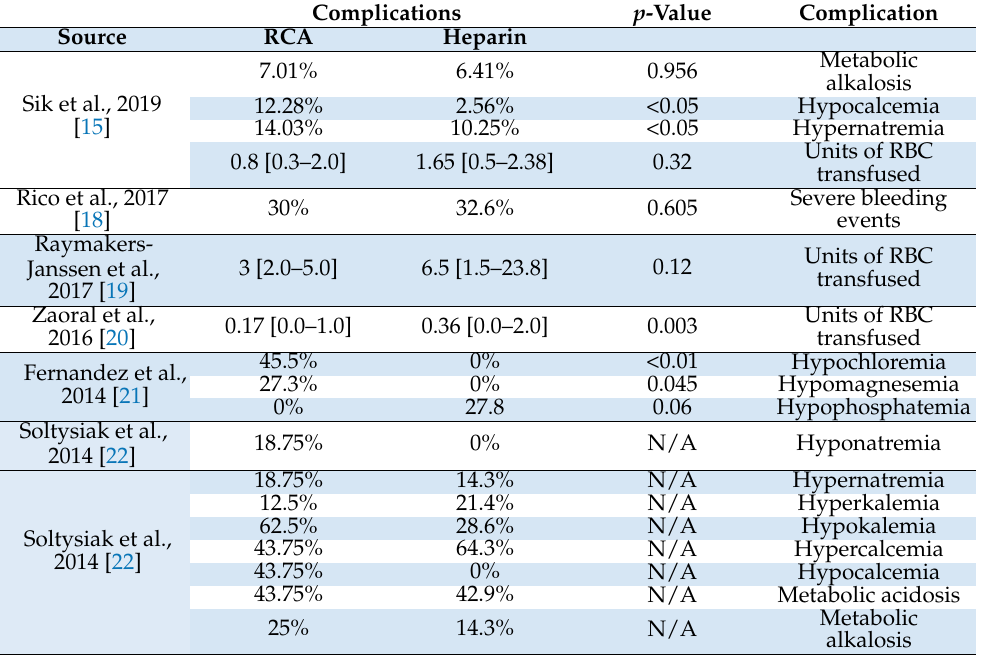
Table 5. Complications according to anticoagulant methods. RCA: regional citrate anticoagulation; RBC, red blood